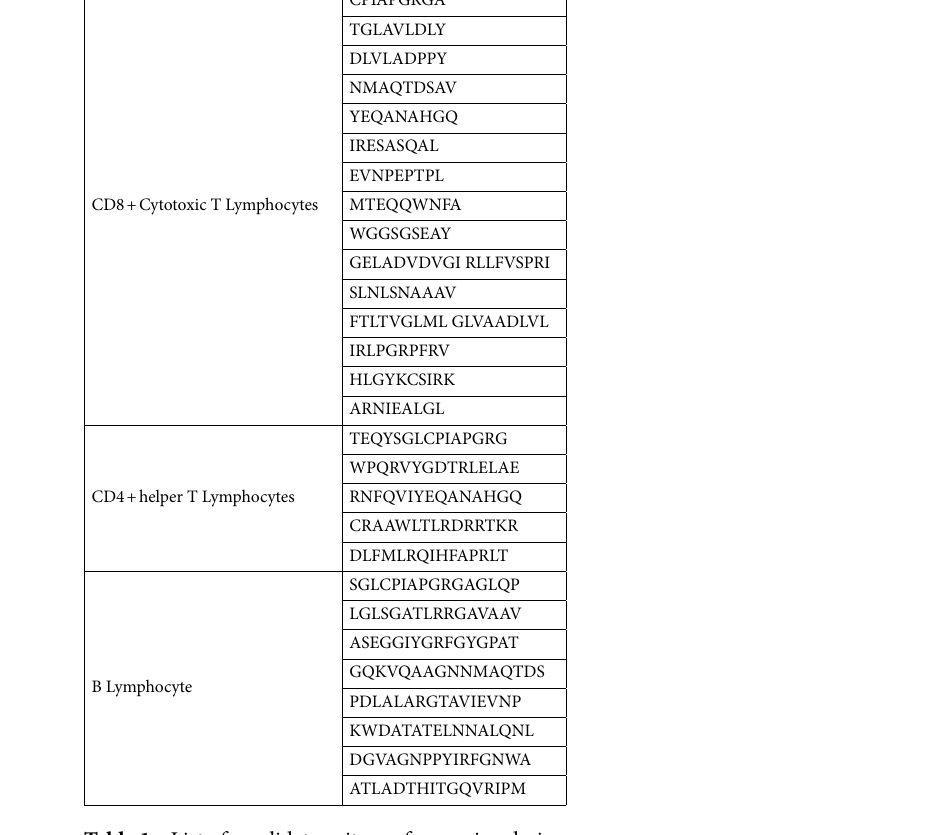
Table 1. List of candidate epitopes for vaccine